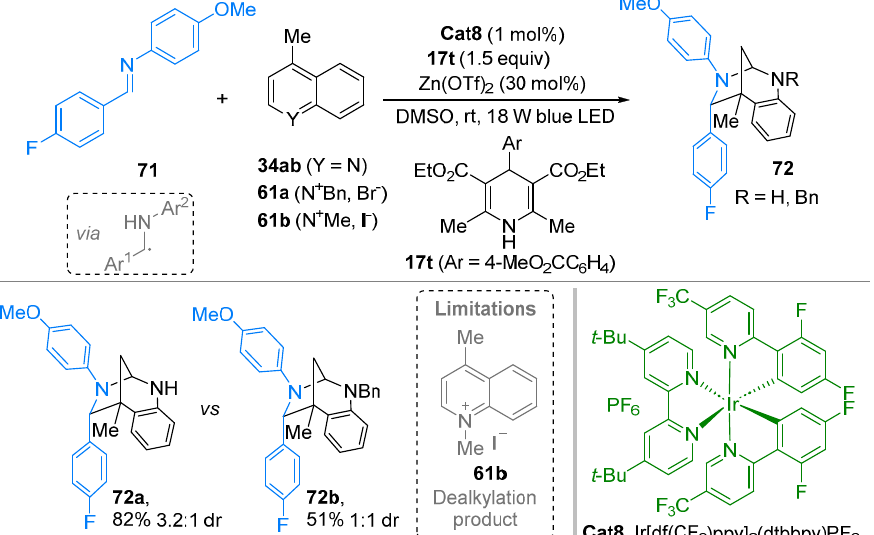
Molecules 2023 , 28 , x FOR PEER Scheme 65. Photoredox-catalyzed reaction of quinolines and quinolinium salts with imines.